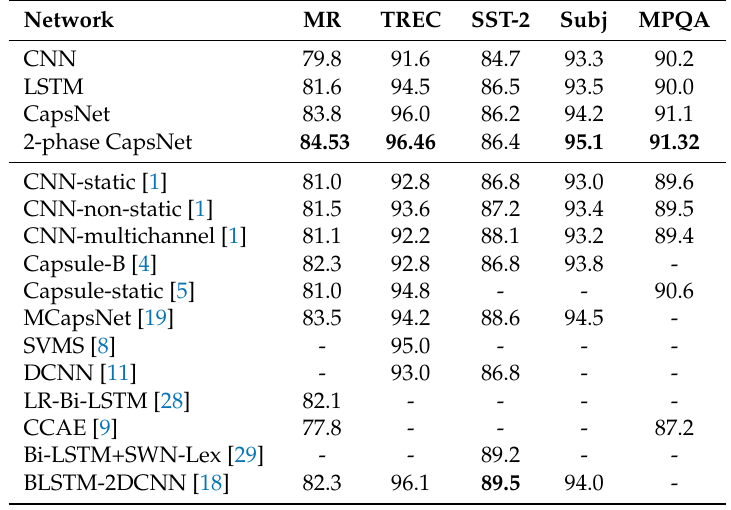
Table 4. Comparison: Accuracy of our CapsNet model and other models on different